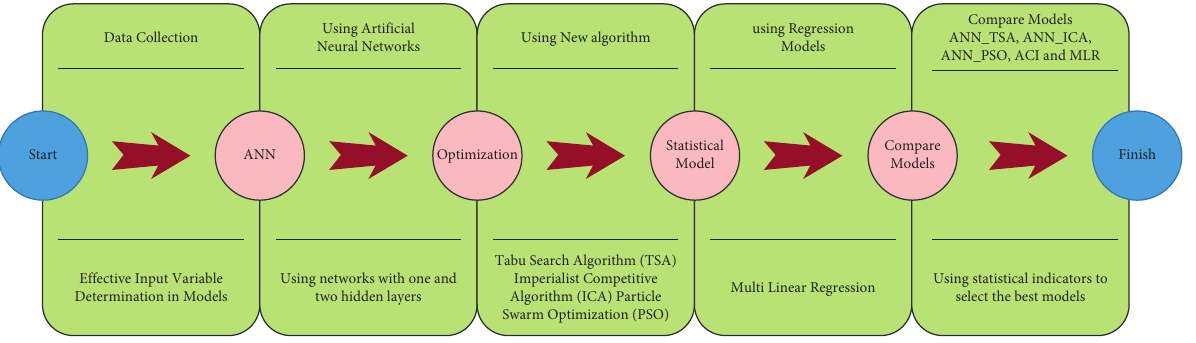
Figure 1: Outline of the paper.